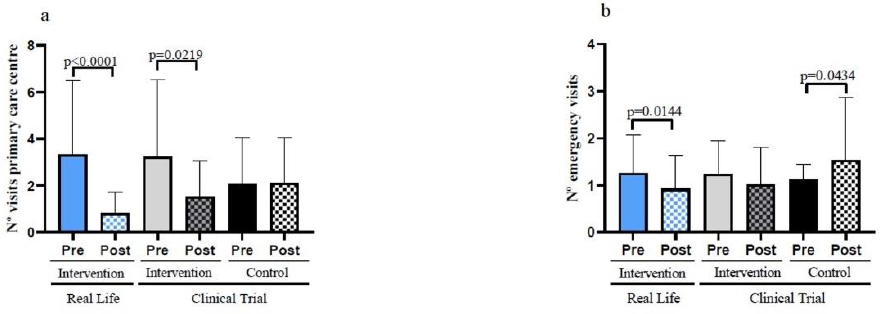
Figure 6. Hospital visits in the previous and later six months of the interventions in the study participants. ( a ) Number of visits to the primary care centres before and after the interventions. ( b ) Number of emergency visits before and after the interventions. Real-Life Intervention n = 50, Clinical Trial Intervention n = 51, Clinical Trial Control n = 49. Bars represent mean ± SD. Statistical analysis was performed with the Student’s t test for paired samples and the Wilcoxon test for non-parametric